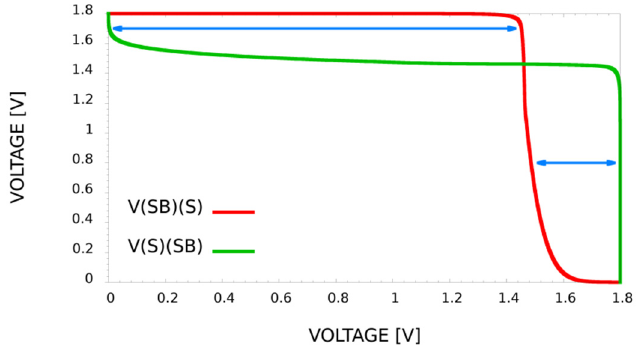
Figure 10. Effect of the R10 defect on SNM.